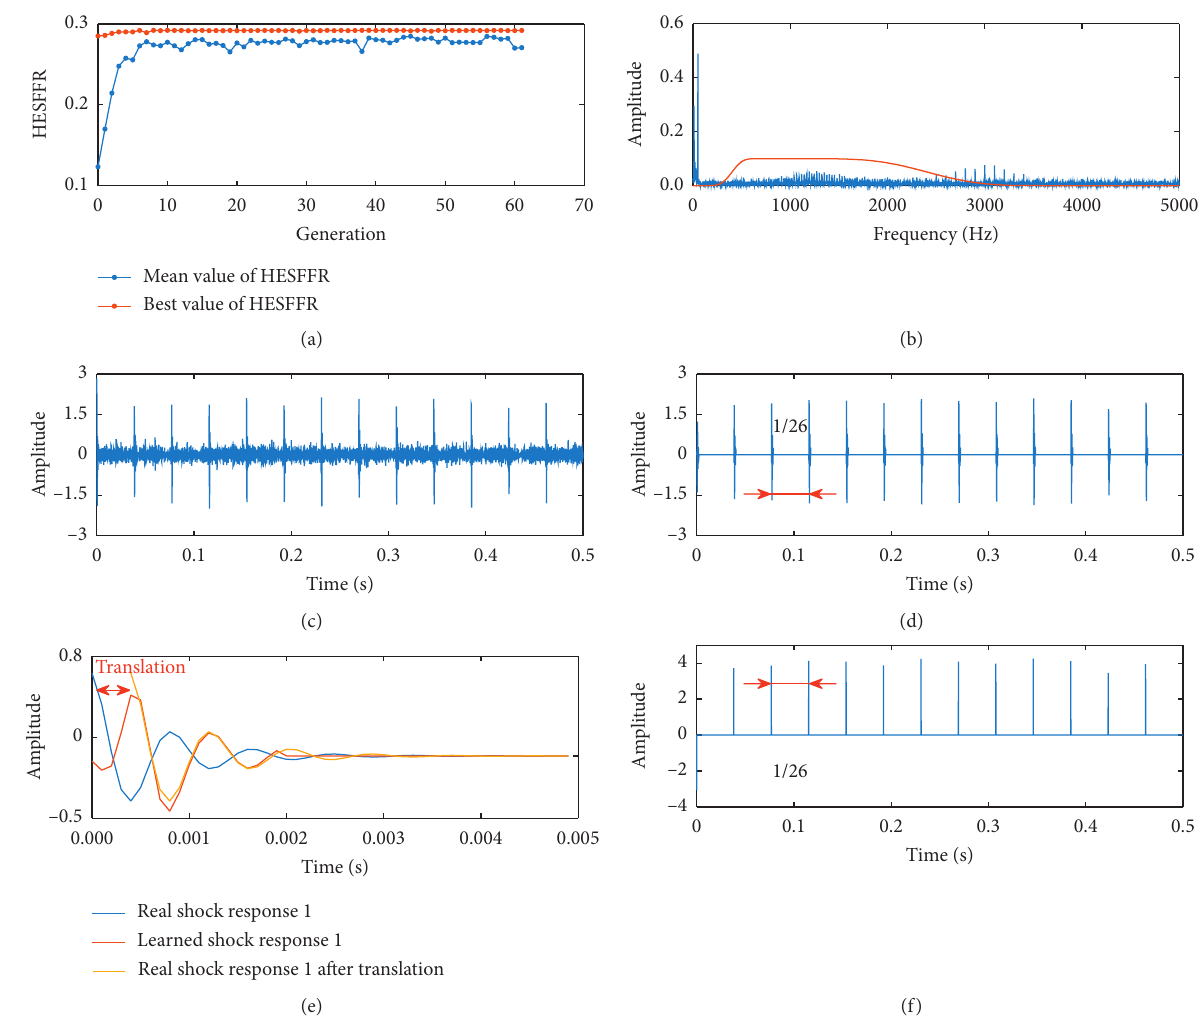
Figure 13: AUC-DLA-OB for detection of fault impulses with the fault characteristic frequency of 26Hz. (a) Convergence process of solving constrained optimization problems; (b) filtering frequency band related to fault impulses; (c) filtered signal by filters in Figure 13(b); (d) sparse reconstruction signal; (e) learned shock response 1; and (f) location coefficients obtained from simulation